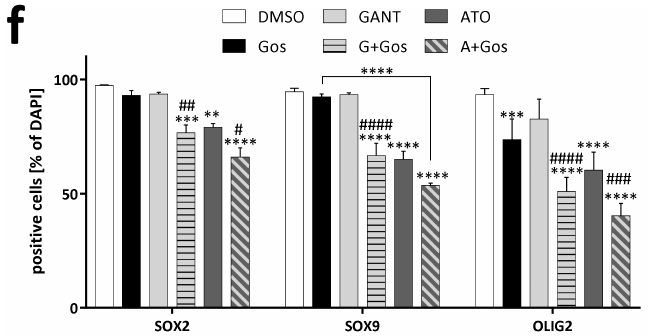
Figure 3. ATO, but not GANT in combination with Gos reduces GSC marker and Hh and Notch pathway activity. ( a , b ) Western Blot analysis of ( a ) GS-5 and ( b ) 17/02 after treatment for 24 h with solvent (DMSO), 7.5 µ M Gos, 5 µ M GANT, 5 µ M ATO or a combination of Gos with GANT